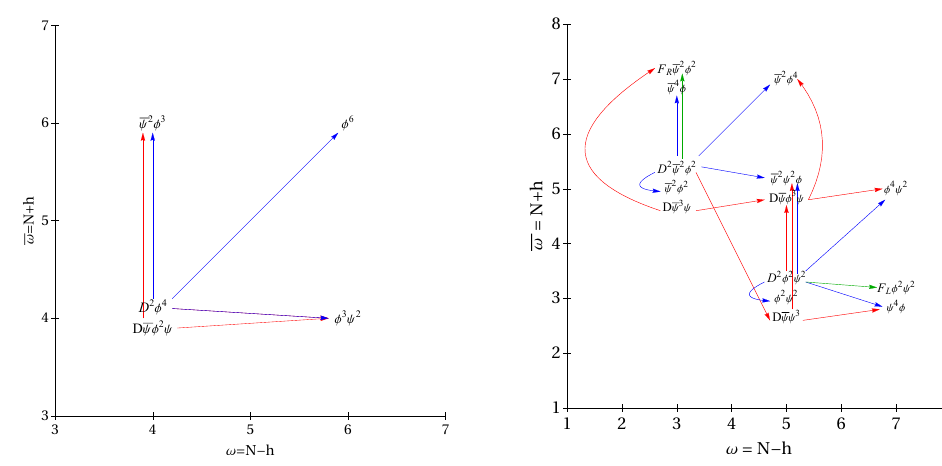
Figure 8 . The Lorentz classes related by the EOM for dimension 6 (left) and dimension 7 (right). Blue arrows relate different operators by the fermion EOM, red arrows indicate the use of the Higgs EOM, green arrows represent the replacement of [ D, D ] by field strength tensors. We did not take into account the Lorentz classes that are not involving any conversion relations, e.g. ψ 2 ¯ ψ 2 and ψ 4 at dimension